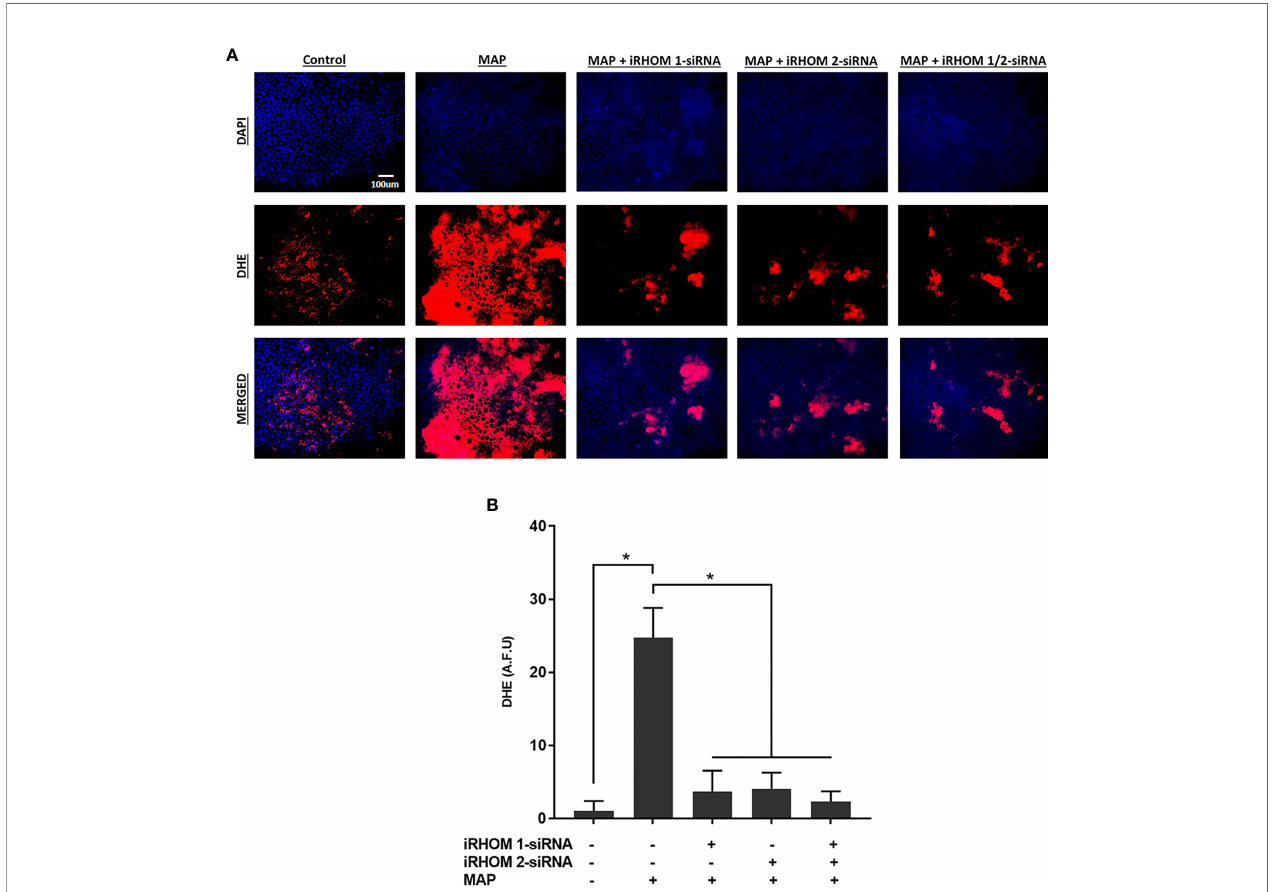
FIGURE 9 | The impact of TACE regression on oxidative stress experienced by co-cultured Caco-2 monolayers. (A) The total nuclei are stained with DAPI blue and the DHE positive cells are stained in red; the merged cells are presented in pink. (B) The quantitative corrected DHE fl uorescence integrated density from Caco-2 cells co-cultured with control and treated THP-1 macrophages. The Kolmogorov – Smirnov normality test was used to test the normal distribution for all values and a two-way analysis of variance (ANOVA) was used to assess signi fi cance among experiments, which was followed by a Bonferroni correction test. All experiments